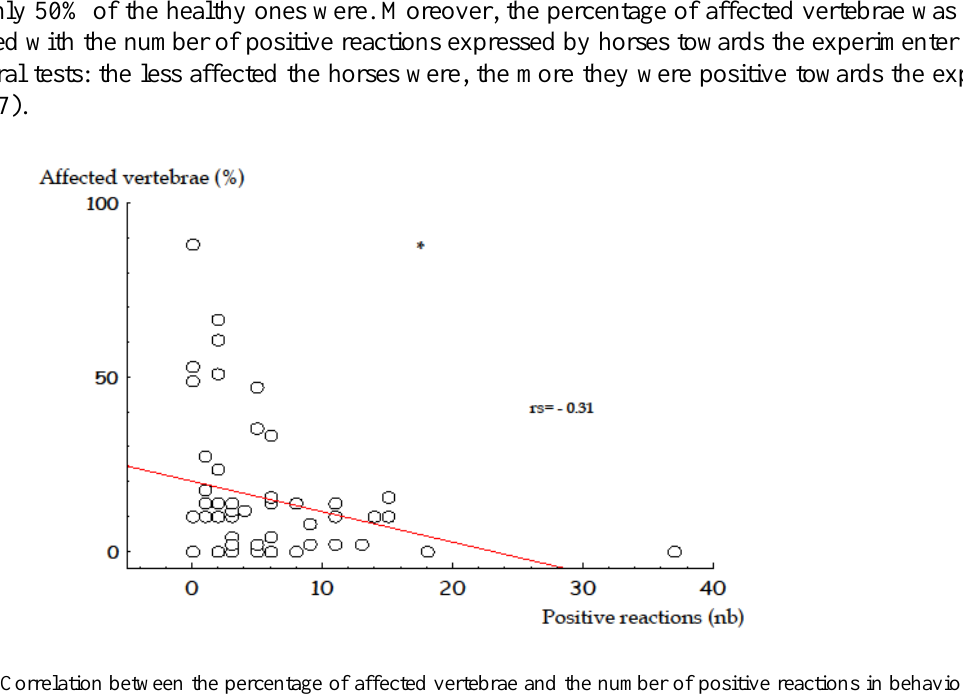
Figure 7. Correlation between the percentage of affected vertebrae and the number of positive reactions in behavioral tests. The more the vertebrae were affected, the less positive reactions the horses made. Spearman correlation test, * p < 0.05. From Fureix et al. (2010), PloS ONE